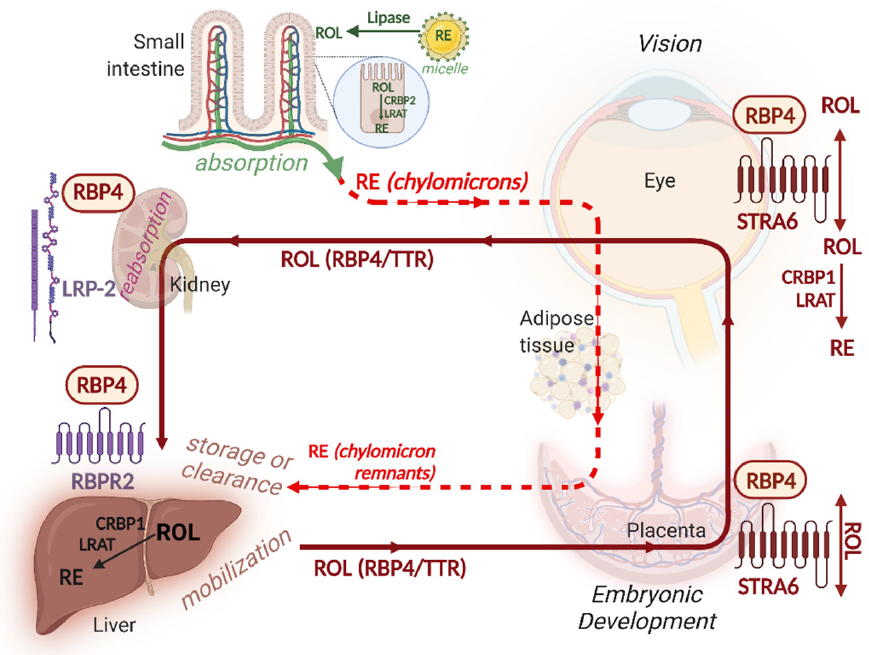
Figure 2. The absorption and delivery of vitamin A. Vitamin A is absorbed from the lumen of the small intestine following hydrolysis of retinyl esters (RE) and re-esterification of retinol via cellular retinol binding protein 2 (CRBP2) and lecithin:retinol acyltransferase (LRAT). REs are secreted by enterocytes as part of chylomicrons and circulate via the lymphatic system (green) and enter the circulation (dashed red). Chylomicrons are hydrolyzed via lipoprotein lipase (LPL) to deliver